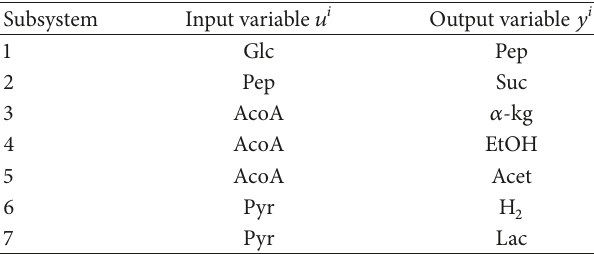
Table 2: Distribution of input-output pairs in the different subsys- tems of the metabolic network.